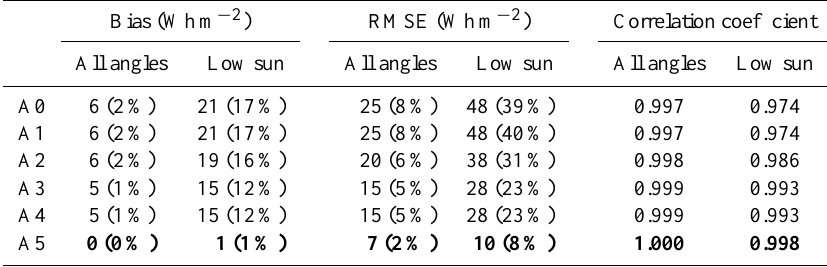
Table 2. Performance of each practice for Carpentras for all angles and the subset “low sun”. Relative values are computed relative to the mean value of B Nh . Best results are in bold.